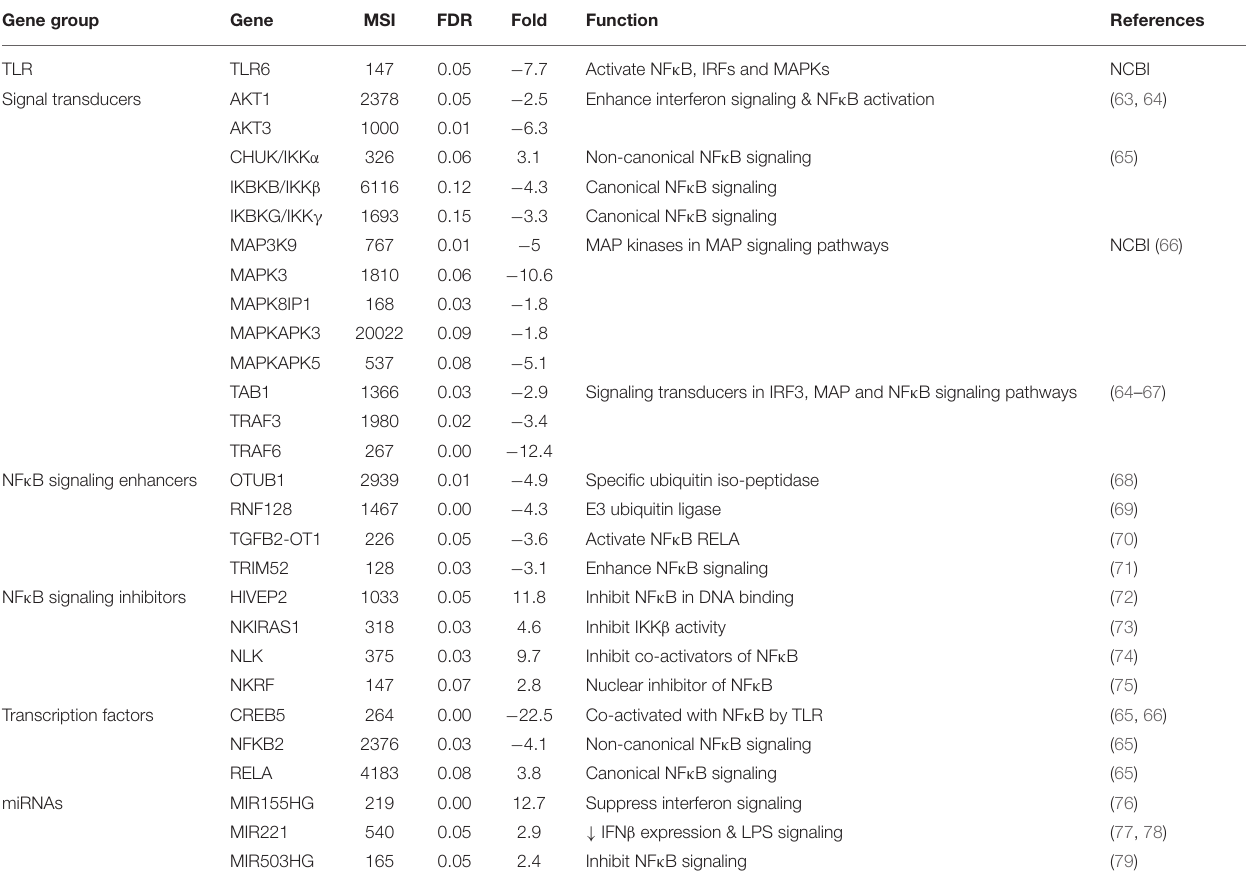
TABLE 5 | Mean expression levels (microarray signal intensity, MSI), false discovery rates (FDR) and fold differences ( + and –values as up- and down-regulated in carriers compared to non-carriers, respectively) of differentially expressed genes in interferon, IRF3, MAP, and NF κ B signaling pathways. Gene